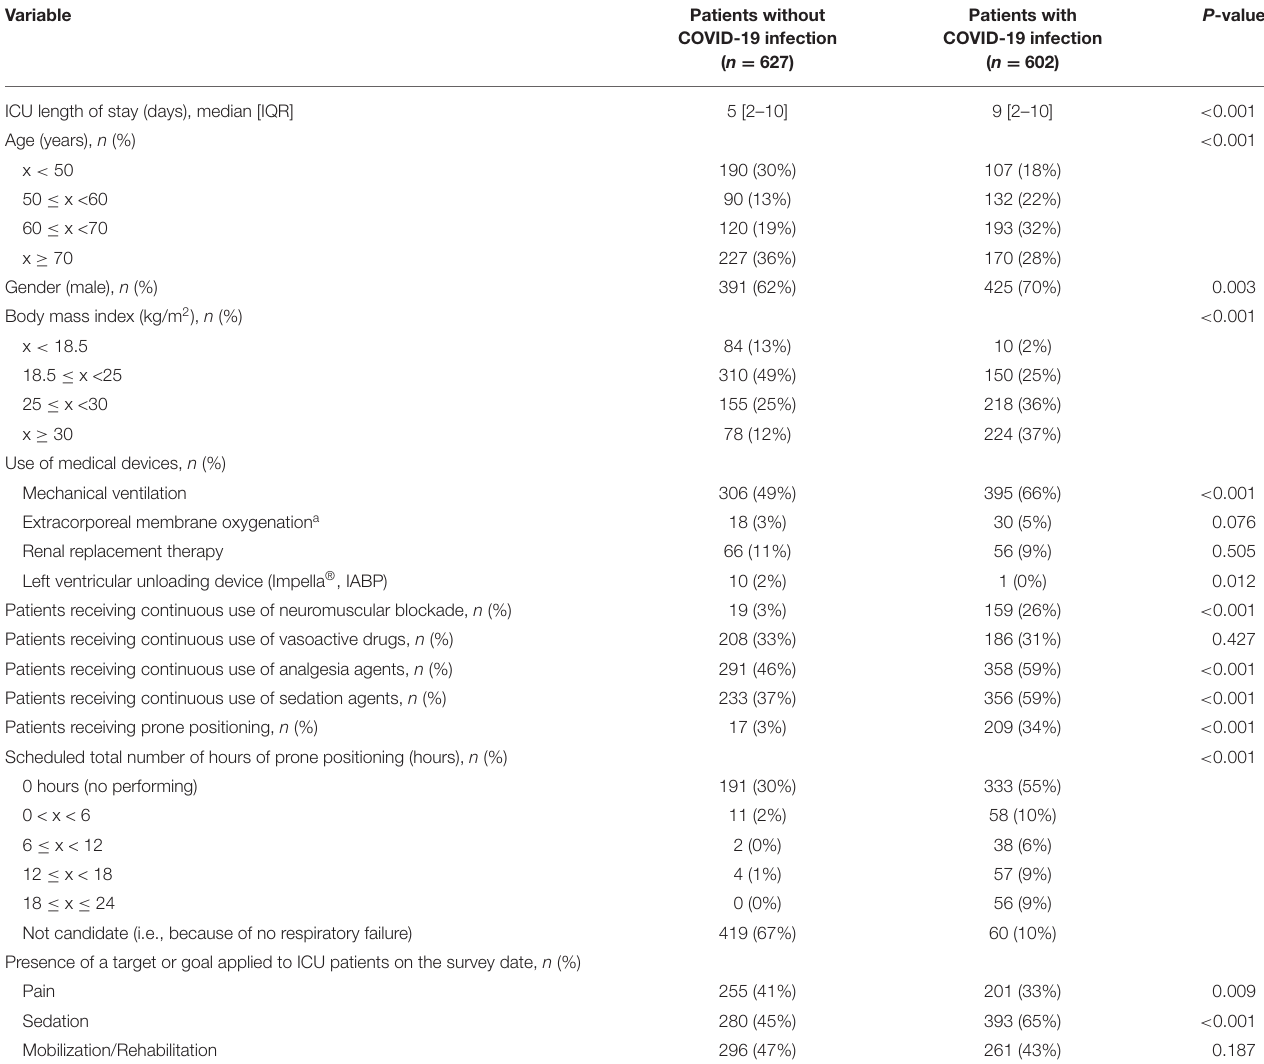
TABLE 3 | Comparison of demographics of patients without and with COVID-19 infections. Variable Patients without